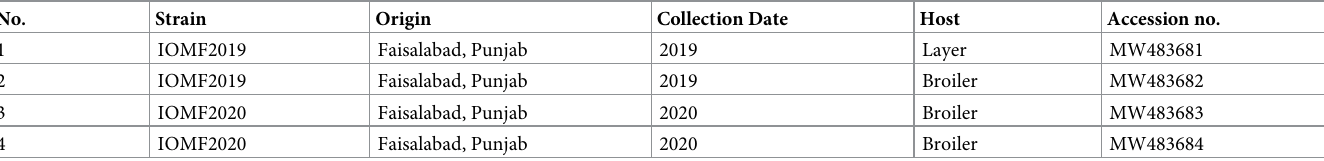
Table 3. Infectious bursal disease virus strains isolated in the study.